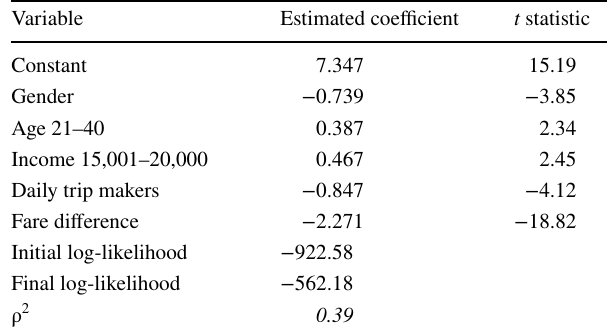
Table 6 Model development (using 1331 data